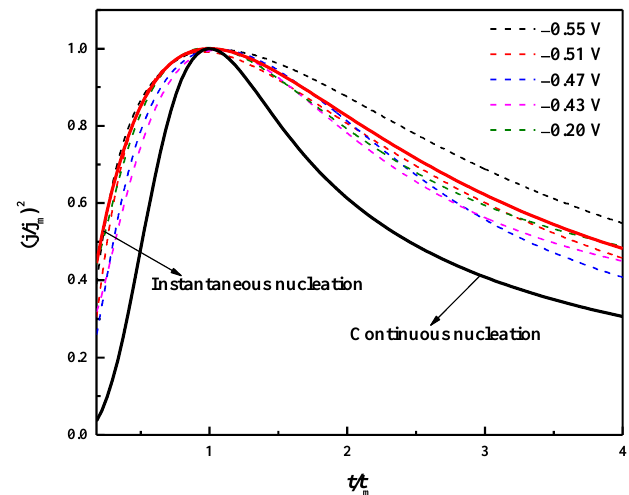
Figure 14. Chronoamperometric experimental data dimension curve and theoretical three- dimensional instantaneous/continuous comparison of nucleation model curves.